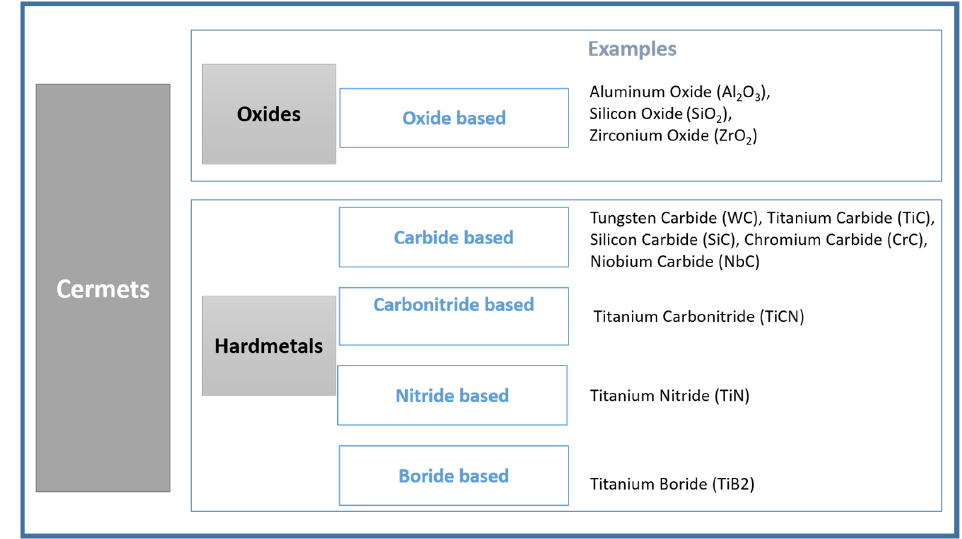
Figure 1. Classification of cermets based on ceramic